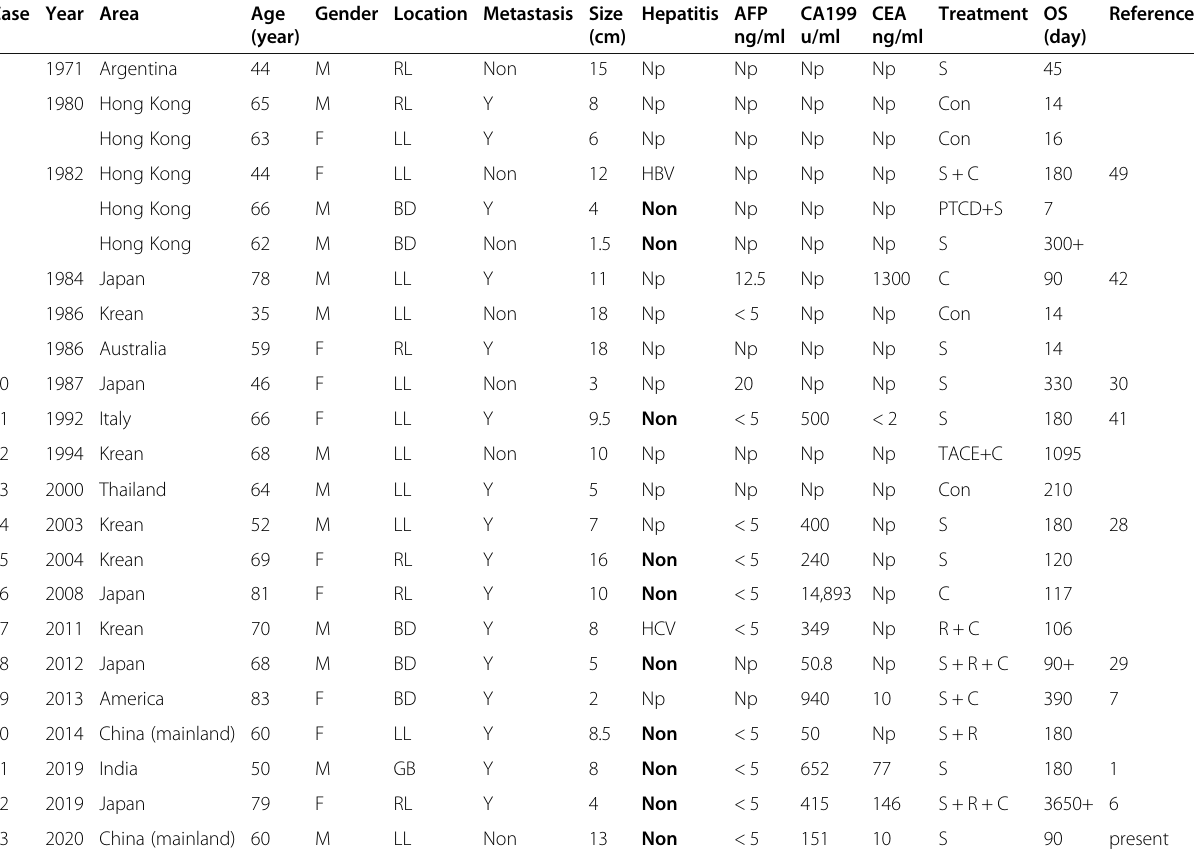
Table 1 Basic characteristics of 23 patients with primary hepatobiliary mucoepidermoid carcinoma, including in the liver, gallbladder and biliary tract, reported in the